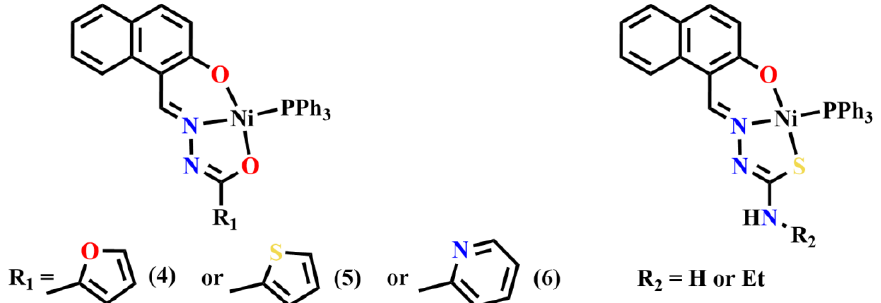
Figure 24. A series of Ni(II) complexes of naphthylhydrazone with furan/thiofuran/pyridine amides or thiourea/ethylthiourea as side chains.